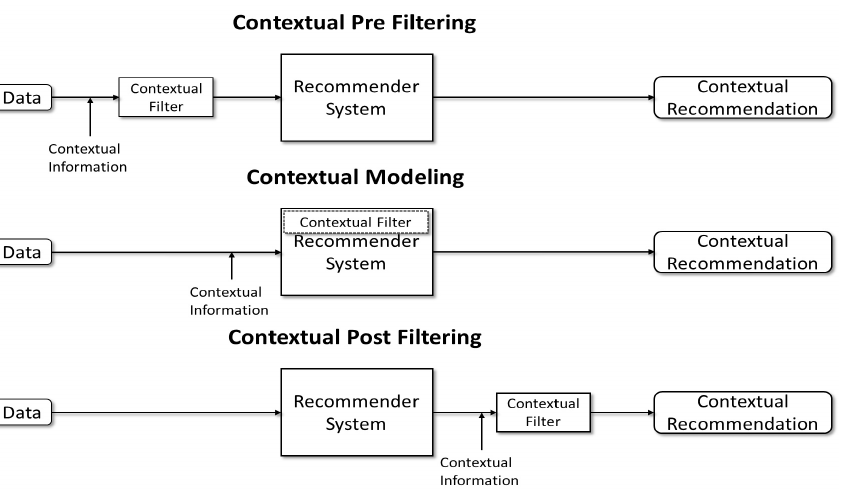
Figure 1. Summary of the contextual information introduction in the Recommendation Phase.